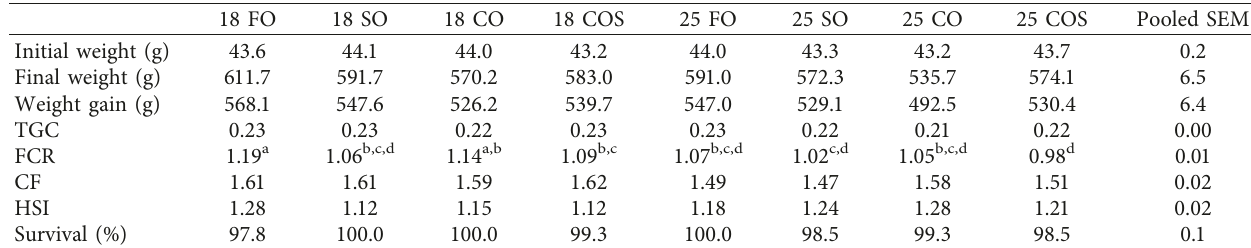
Table 3: Effect of fish oil replacement with soybean oil, canola oil, and a blend of canola oil and Schizochytrium sp. biomass on rainbow trout growth, nutritive utilization, and somatic parameters after growth trial. 18 FO 18 SO Pooled SEM Initial weight (g)